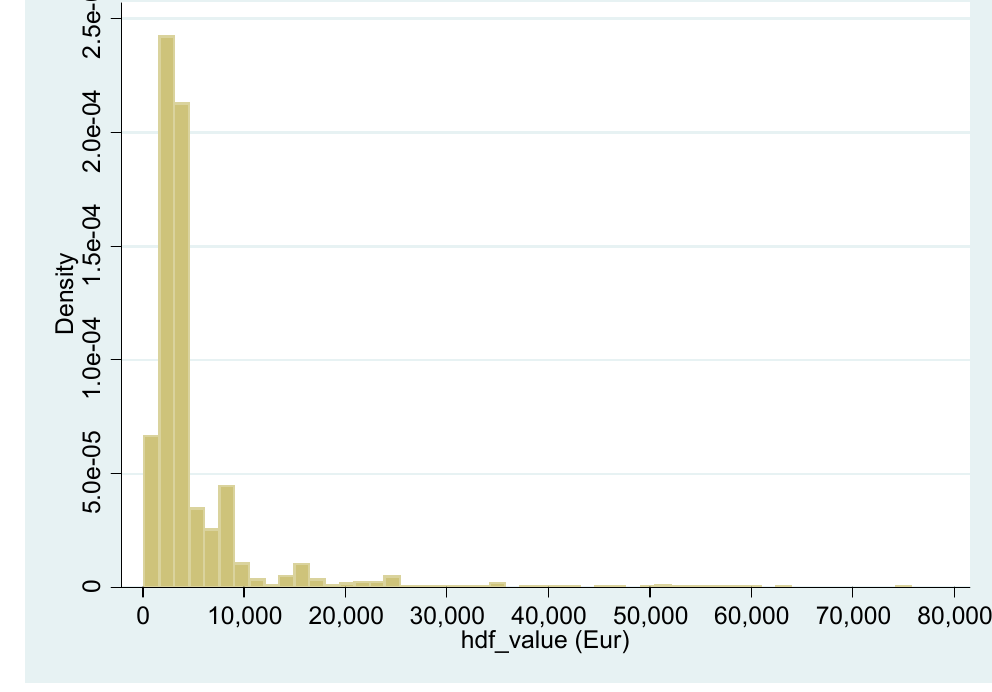
Figure 1. Histogram of hdf_value .